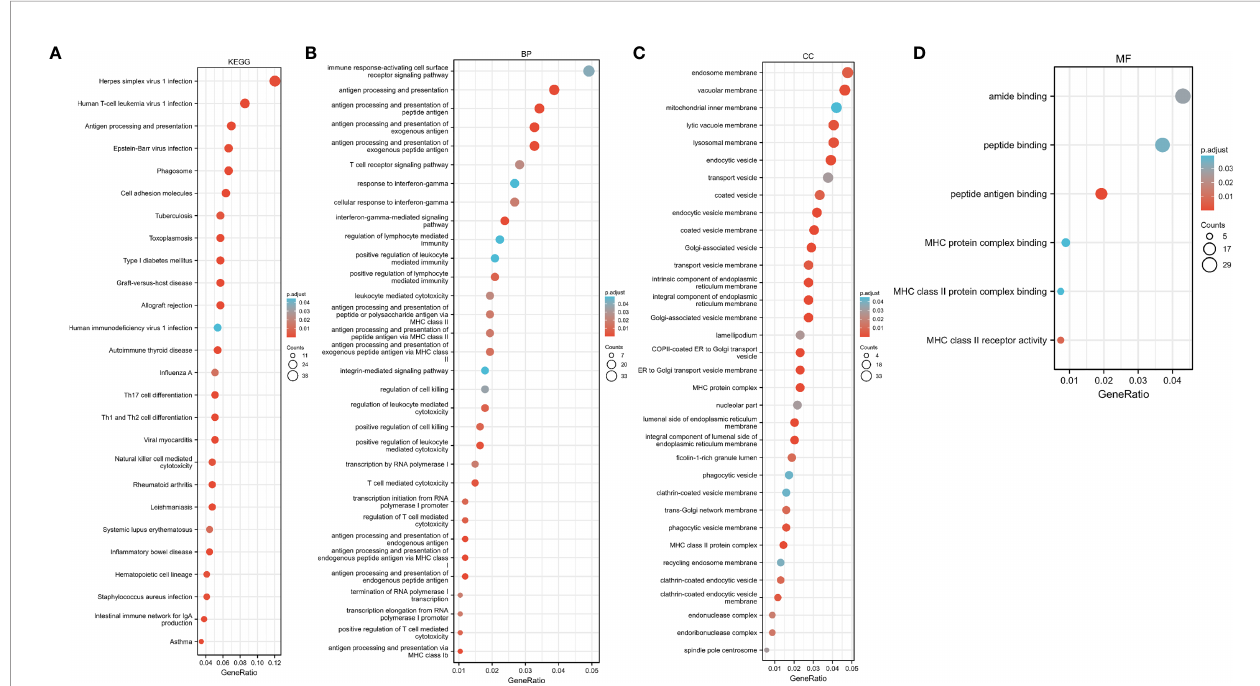
FIGURE 4 | Network diagram of GO term analysis for TWAS-identi fi ed genes, where each circular point in the network represents a term whose size is proportional to the number of input genes for that term. (A) KEGG; (B) BP; (C) CC; (D) MF.